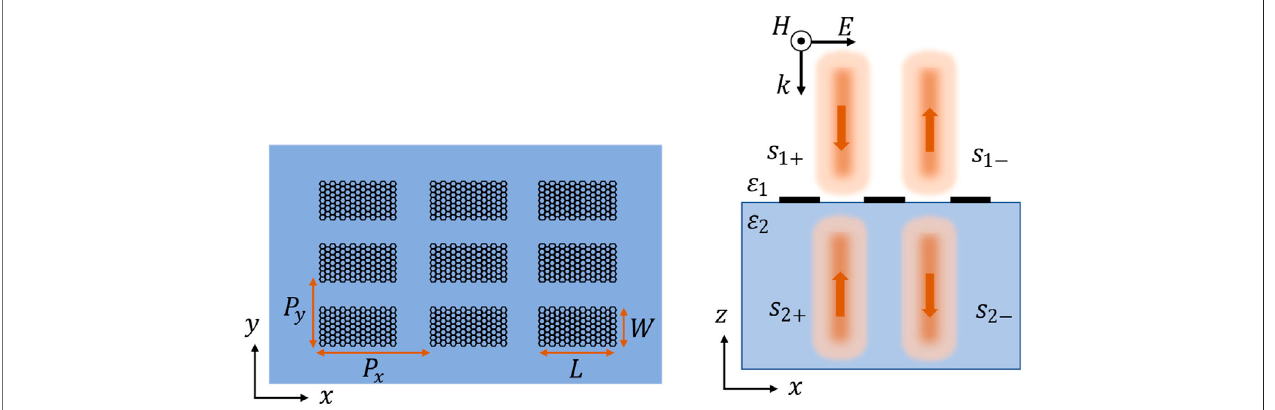
FIGURE 1 | Schematic depiction of the graphene cut-wire array. The array is located on a dielectric substrate (left) , where the THz wave illuminates the sample perpendicularlyeitherfromtheairordielectricside.ThepolarizationoftheTHzwaveisalongthe x -axis.Theperiodsofthearrayalongthe x -and y -axesaredenotedas P x and P y , respectively. Parameters L and W delegate the length and width of the cut-wire, respectively. The array can be fabricated by e-beaming lithography (Guo et al., 2018) or standard optical lithography followed by oxygen plasma etching process (Ju et al.,